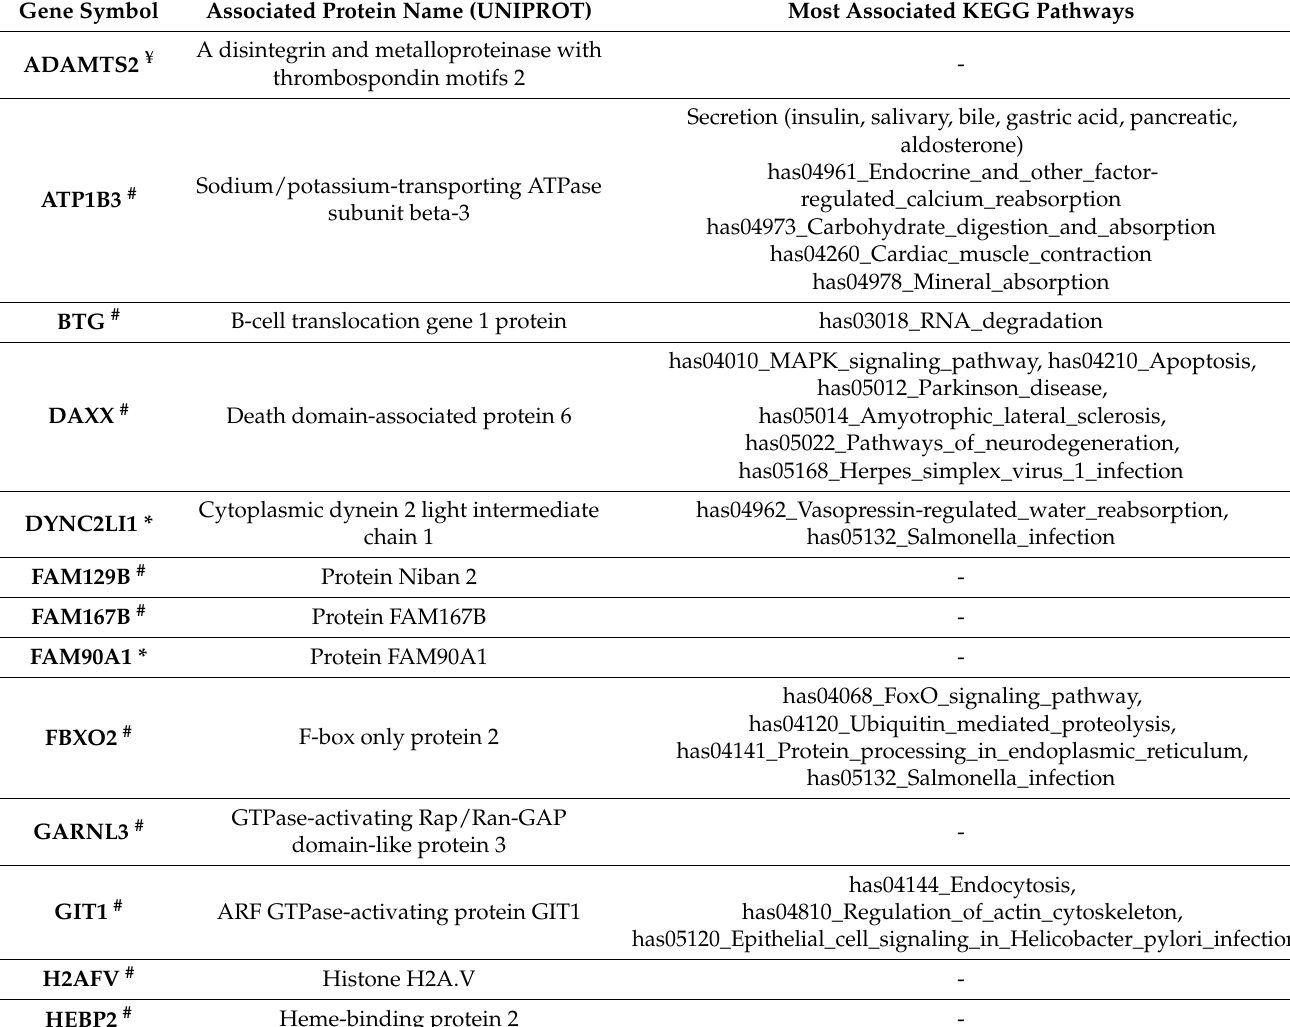
Table 2. Gene symbols of all shared DEGs, synthesised proteins and the most associated KEGG pathways for them. ( ¥ ) up-regulated in DLPFC and TCX, down-regulated in CBE, (#) up-regulated in all, (*) down-regulated in all. Gene Symbol Associated Protein Name (UNIPROT) Most Associated KEGG Pathways ADAMTS2